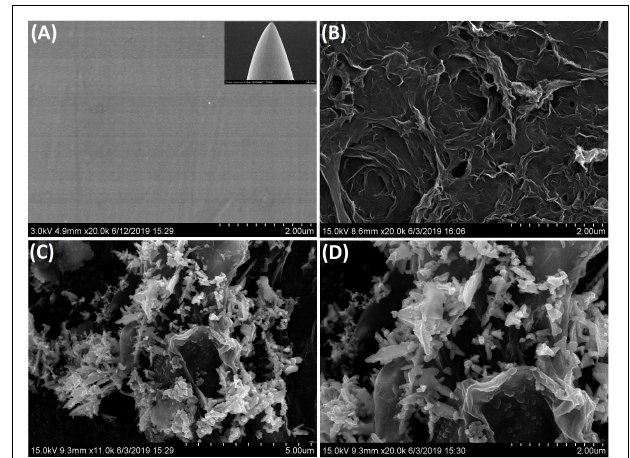
FIGURE 2 | SEM images of the bare ANE (A) , 3DrGO/ANE (B) , and 3DrGO/F-BiNSs/ANE (C,D) . Inset in (A) shows the low magnification of bare